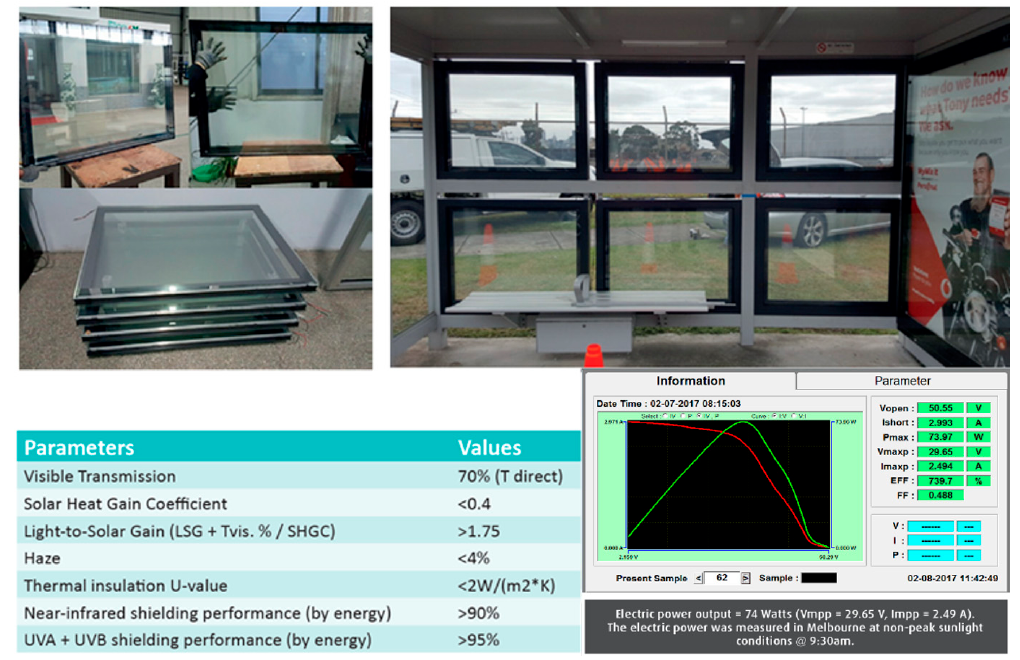
Figure 7. Transparent photovoltaic wall of windows installed into a Port Melbourne bus stop powering an advertising display and lighting appliances. Several unframed PV window modules are also shown during factory assembly process at Qingdao Rocky Ltd. (Qingdao, China), which is shown on the left.